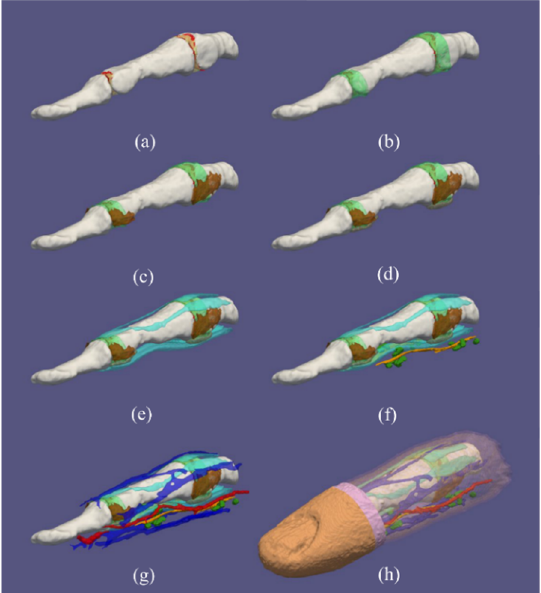
Figure 2. Three-dimensional rendering of the human index finger model from the middle part of the proximal phalanx to the distal phalanx depicting different tissue types (TTs): ( a ) cartilage (red),